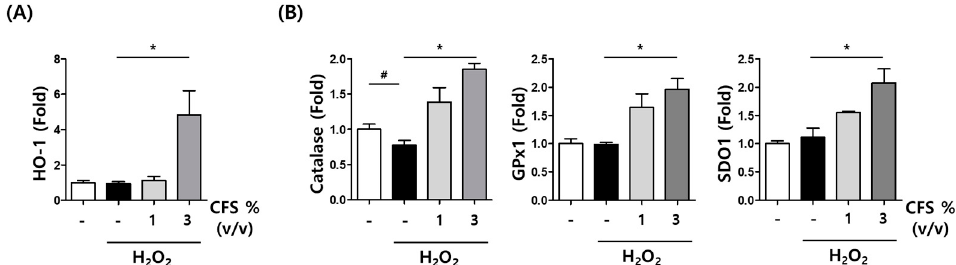
Figure 8. Antioxidant effects of CFS on H 2 O 2 -induced oxidative stress. HaCaT cells were preincu- bated with CFS at the concentration of 1 or 3% ( v / v ) for 30 min and then incubated with H 2 O 2 (10 µM) for 24 h. qRT-PCR analysis for ( A ) HO-1 and ( B ) CAT , GPX1 , and SOD1 . Data are presented as mean ± SEM. # p < 0.05 compared with control. * p < 0.05 compared with H 2 O 2 treated group, respec- tively.